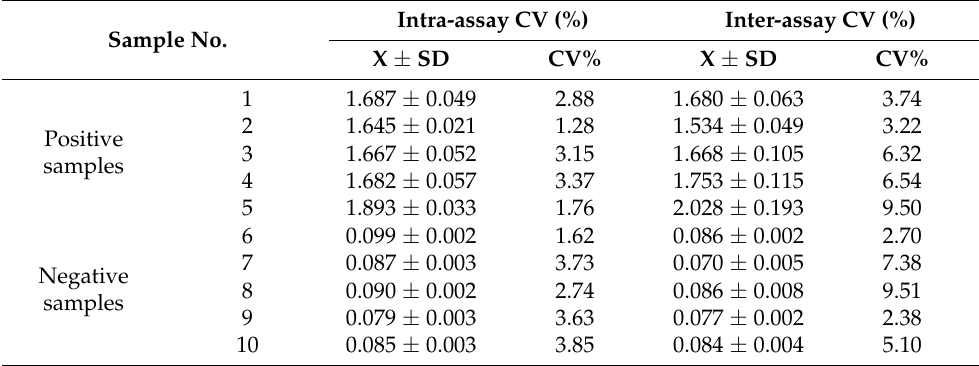
Table 2. Results of the repeatability assay for DAgS-ELISA. Sample No.